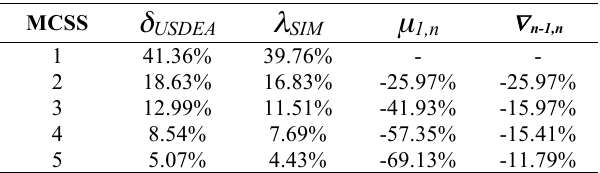
Table 5. Effect of Increasing MCSS, Communications Range